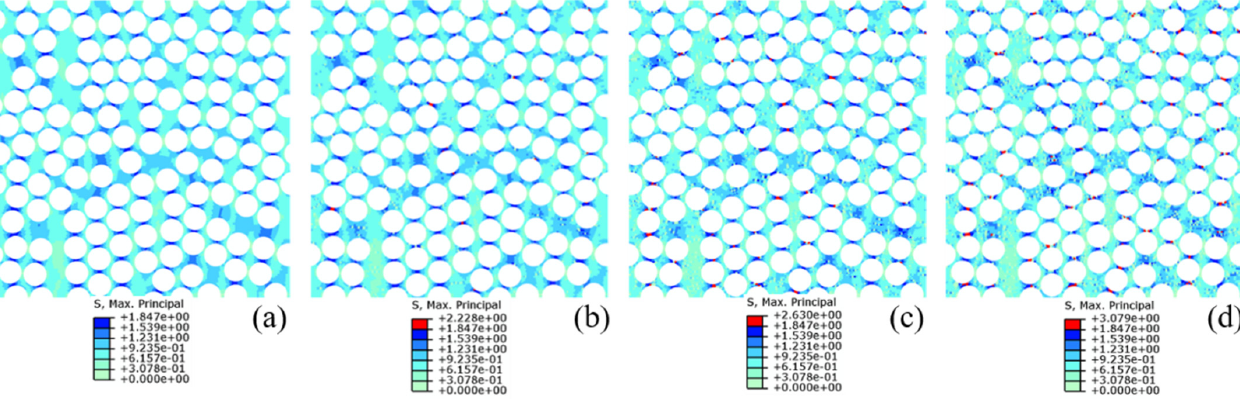
Figure 8. Maximum principal stress plots of microscale matrix component under transverse tensile load: ( a ) 0%, ( b ) 1%, ( c ) 3% and ( d ) 5%.